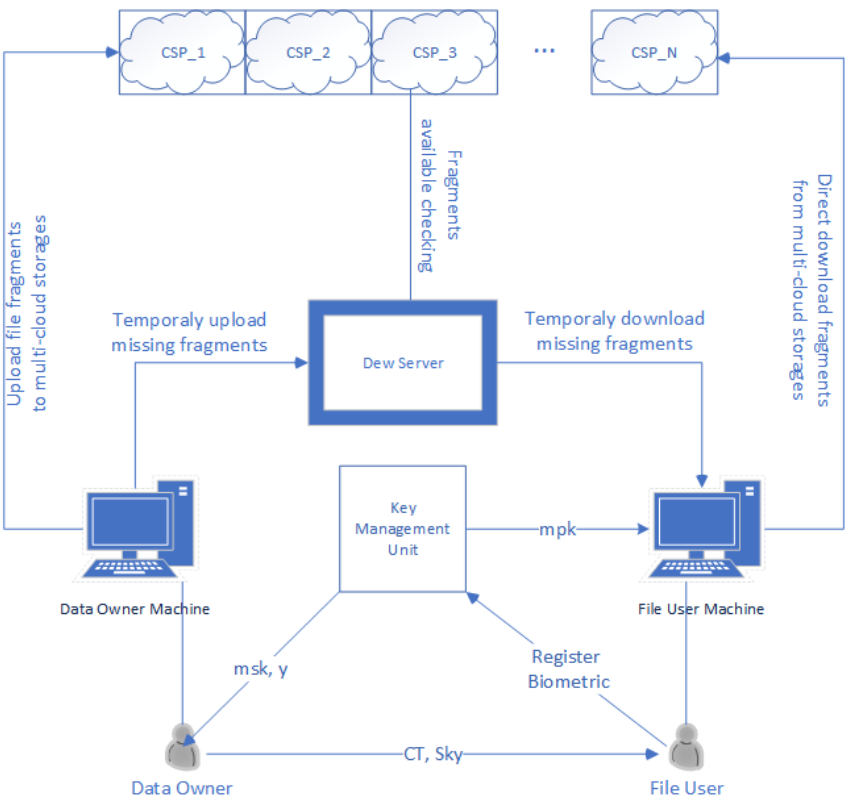
Figure 3. The proposed architecture of dew computing and asymmetric security framework for big data file